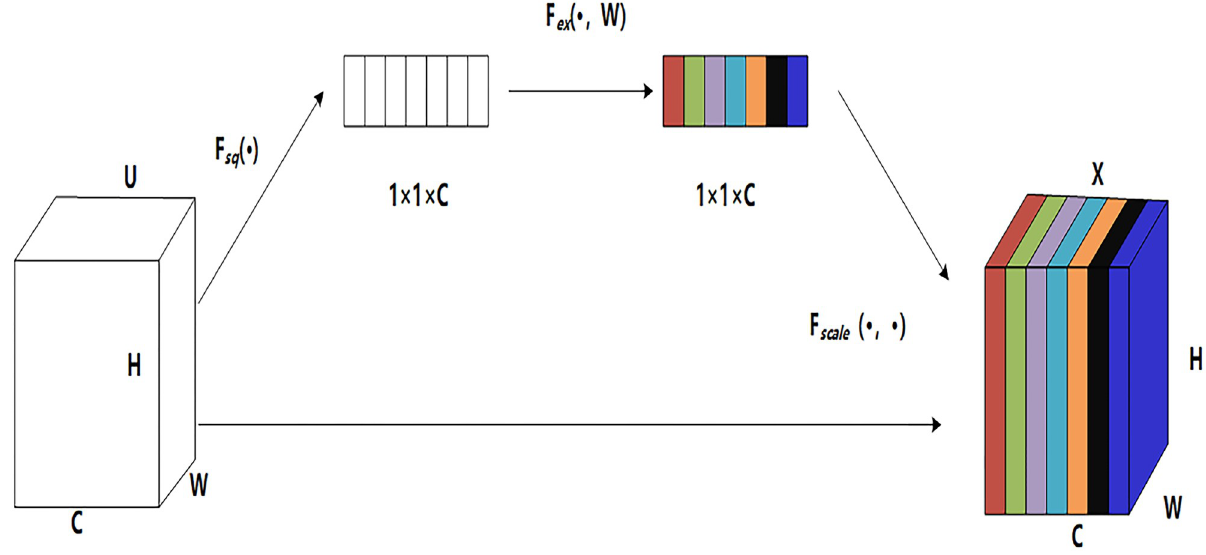
Fig 2. SE module.